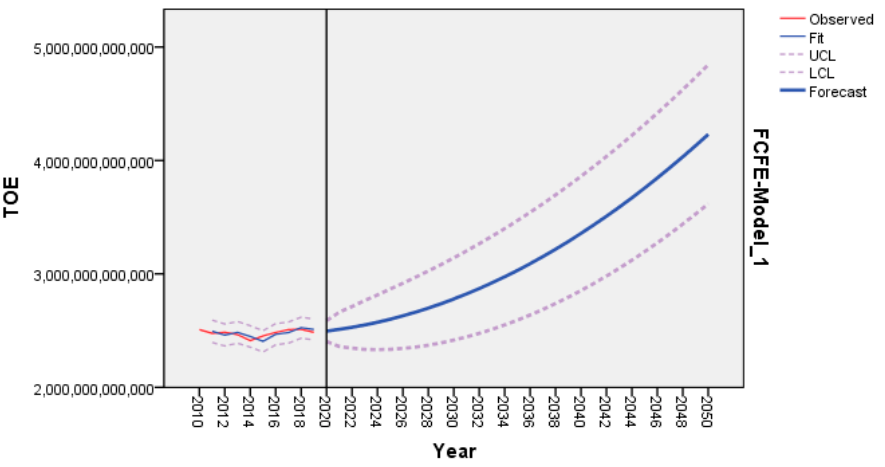
Figure 3. Forecast for developments in final energy consumption for the electricity source. Notes: UCL—upper-case limits; LCL—lower confidence limits. Source: developed using SPSS v.20.